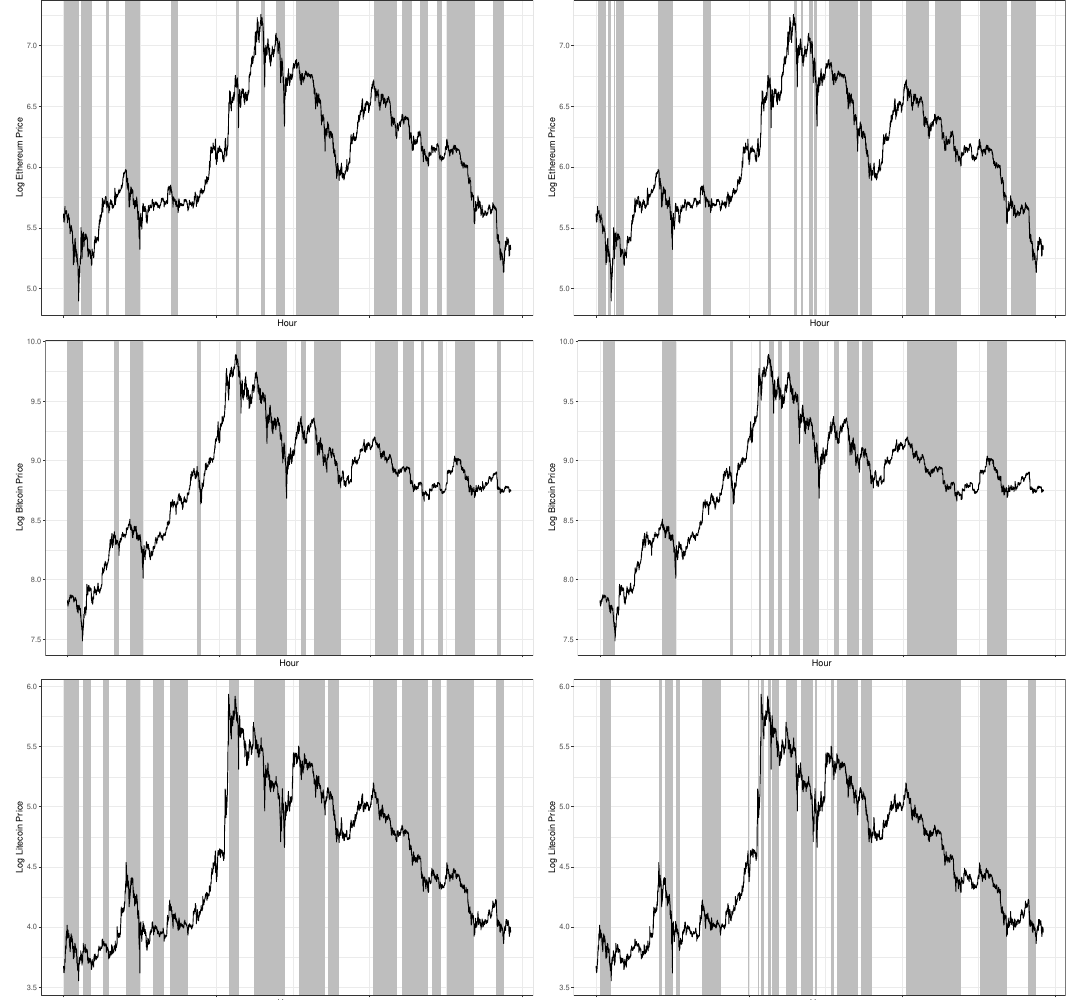
Figure 1. Plots indicating bull–bear periods using Ethereum ( top left ) dating and ( top right ) filtering algorithm, Bitcoin ( middle left ) dating and ( middle right ) filtering algorithm, and Litecoin ( bottom left ) dating and ( bottom right ) filtering algorithm. Bull and bear periods indicated by white and grey shaded areas,